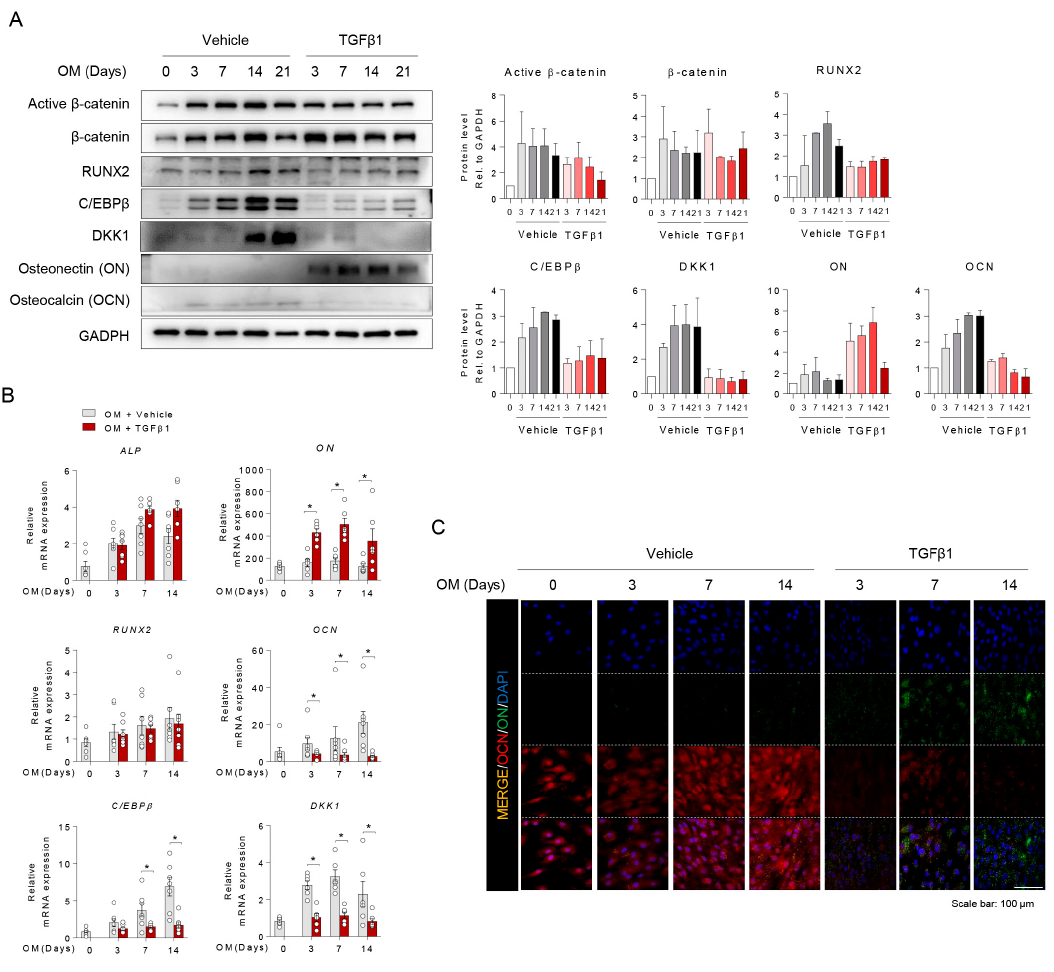
Figure 2 . TGF β 1 downregulated CCAAT/enhancer-binding protein beta (C/EBP β ) and Dickkopf 1 (DKK1) expression in osteoblast differentiation. Osteoprogenitors were differentiated into osteoblasts with vehicle or TGF β 1 (10 ng/mL) for the indicated days. At the days indicated, osteogenic differentiation activity was analyzed. ( A ) Immunoblotting with active β -catenin, β -catenin, RUNX2, CCAAT/enhancer-binding protein beta (C/EBP β ), DKK1, ON, OCN, and GAPDH were analyzed and quantified with Image J and normalized to GAPDH. ( B ) RT-qPCR with ALP, COL1A1, ON, OCN, RUNX2, C/EBP β , and DKK1 were analyzed and normalized to GAPDH ( n = 5). ( C ) Immunostaining with OCN (red), ON (green), and DAPI (blue) were analyzed and immunofluorescence images are representative from the three independent experiments; scale bar is 100 μ m. Values are expressed as the mean ± SD. * p < 0.05.